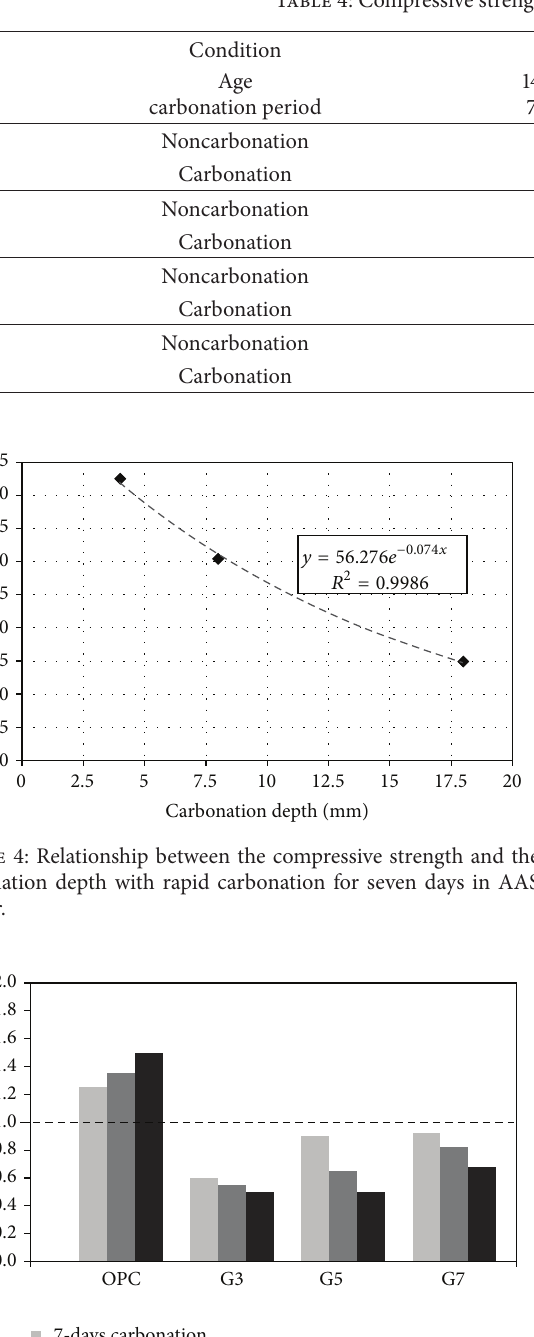
Table 4: Compressive strength of the mortar mixes (unit: MPa).